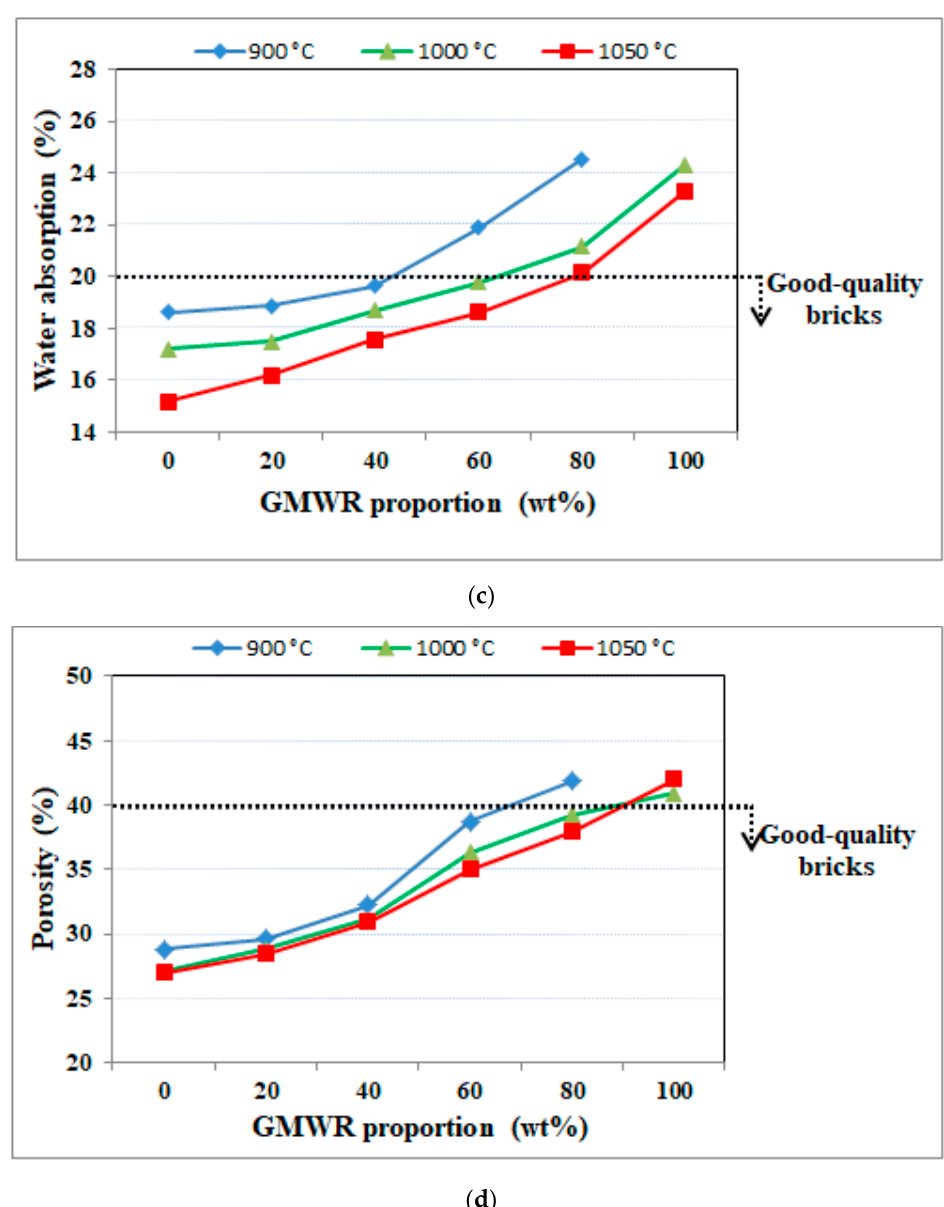
Figure 8. The evolution of mechanical and physical properties of the fired bricks incorporating up to 100% GMWRs. ( a ) flexural strength; ( b ) bulk density; ( c ) water absorption; ( d ) porosity.